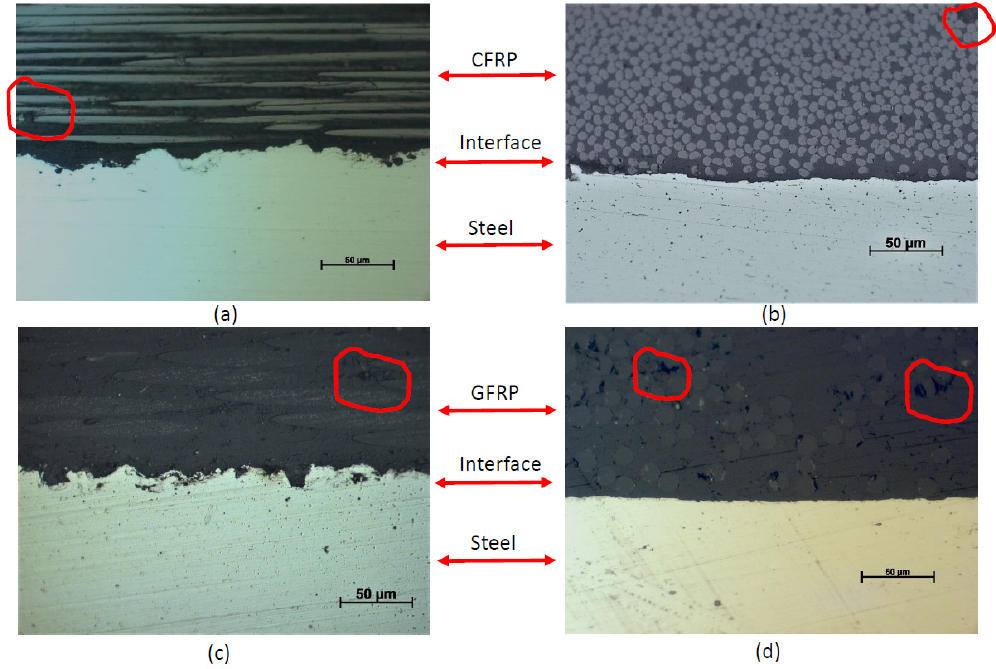
Figure 8. Cross-sections highlighting the microstructures of ( a ) CFRP/steel sample cut along the fiber direction, ( b ) CFRP/steel sample cut perpendicular to the fiber direction, ( c ) GFRP/steel sample cut along the fiber direction and ( d ) GFRP/steel sample cut perpendicular to the fiber direction, in the direct vicinity of the interface of the dissimilar materials (dominant defects in the FRPs are highlighted with red circles).